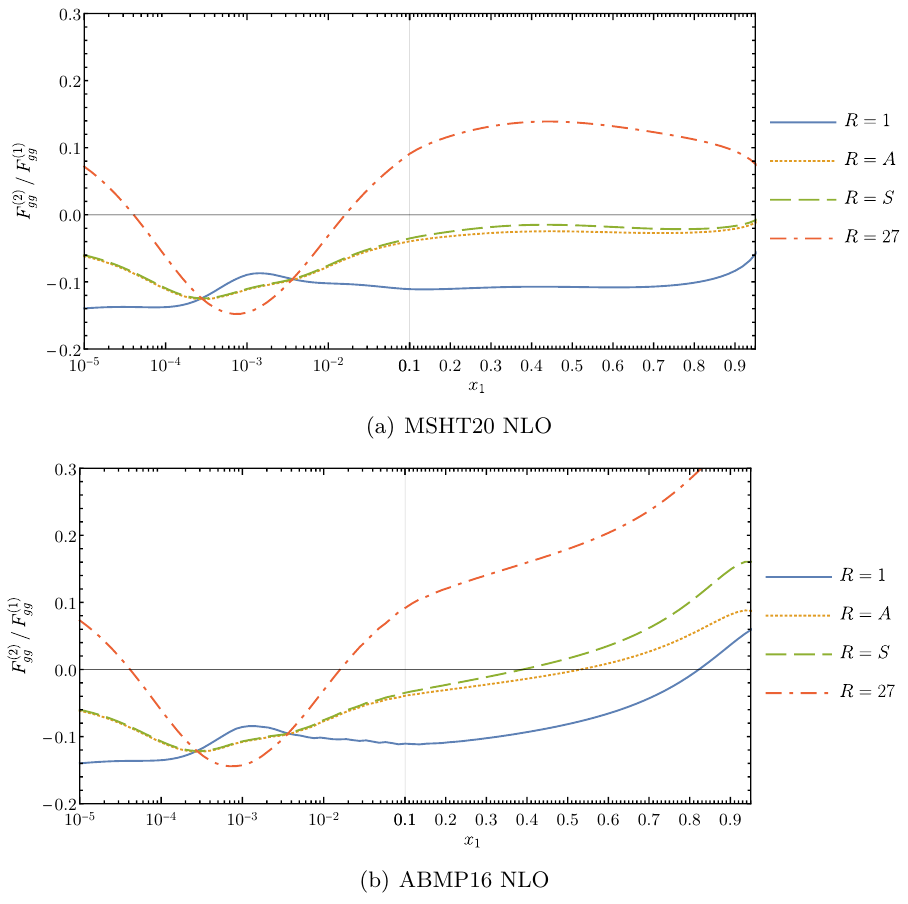
(cid:14) RR Figure 11 . The ratio RR F (2) gg F (1) gg for x 2 = 10 − 3 , evaluated at central scales for different PDFs. The corresponding plot for the CT14 NLO set is in figure